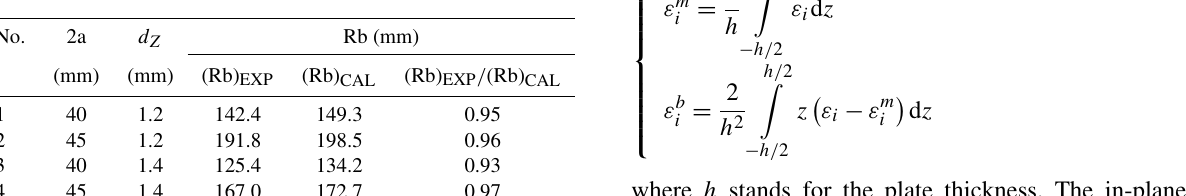
Table 2. Comparison of experimental and FEM results (Yoon et al.,